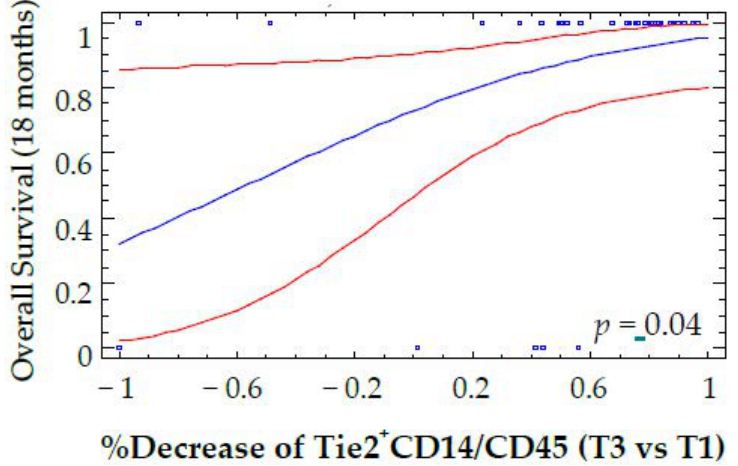
Figure 5. Correlation between the percent decrease of Tie2 + CD14 / CD45 + cells and overall Survival. The percentage of Tie2 + CD14/CD45 + cells was determined by flow cytometry before (T1) and at the end of anti-angiogenic therapy (T3). The reduction in Tie2 + CD14/CD45 + cells was plotted as a continuous variable of overall survival computed by a logistic regression model (blue line and its 95% confidence intervals red lines) with a time fixed at 18 months. Blue squares on the top indicate that corresponding patients are alive, while blue squares on the bottom correspond to patient death.